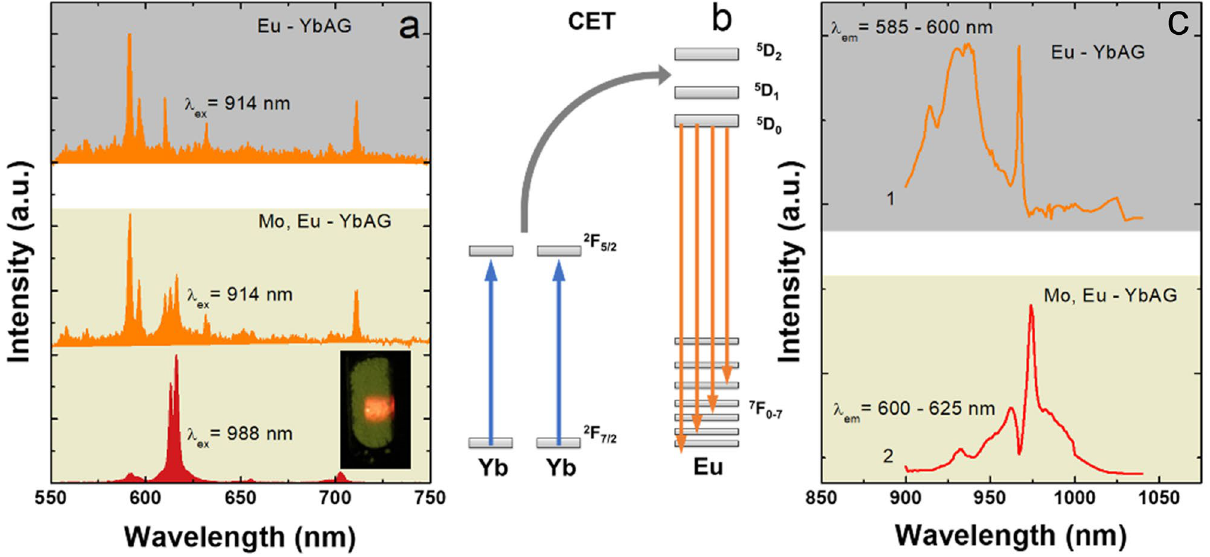
Figure 8. Eu upconversion emission ( a ) and excitation spectra ( c ) of (Mo), Eu-YbAG; A schematic illustration of the Yb-Eu cooperative upconversion (CET) mechanism is also included ( b ). The digital photo presents the Mo, Eu-YbAG emission upon 988 nm